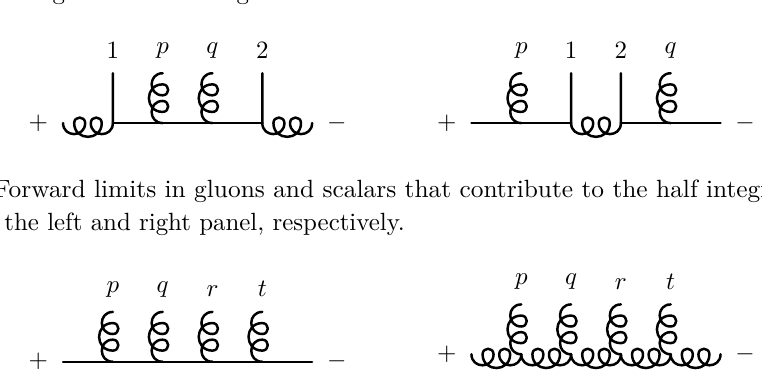
Figure 9 . The forward limits contributing to the integrand in (4.20) are performed in scalars of tree-level half integrands with two gluons and four scalars.